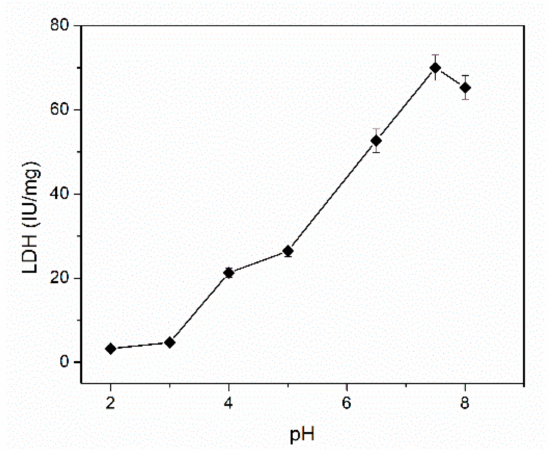
Figure 3. Influence of pH on the enzymatic activity of L-LDH ( n =